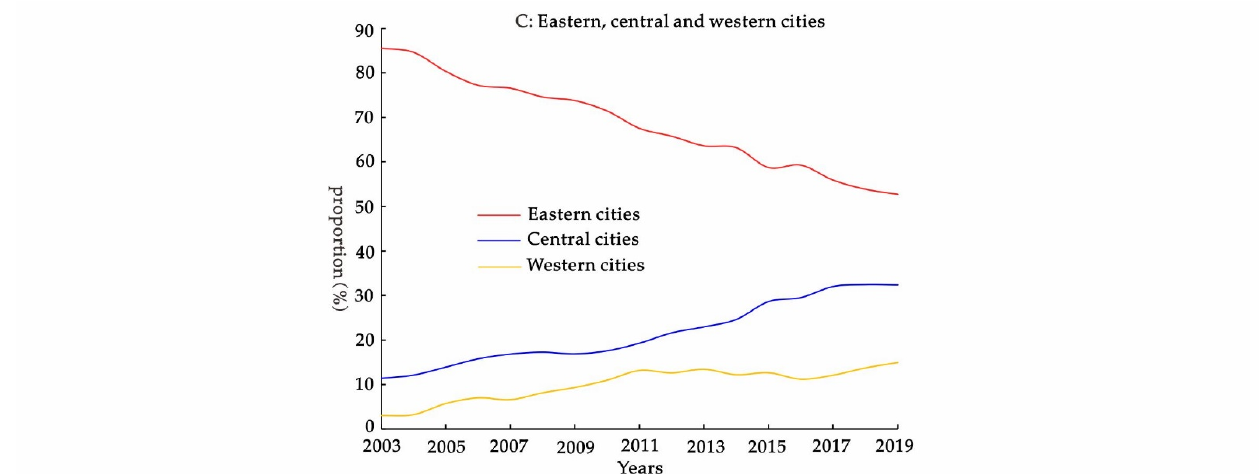
Figure 4. Changes in FDI from 2003 to 2019.